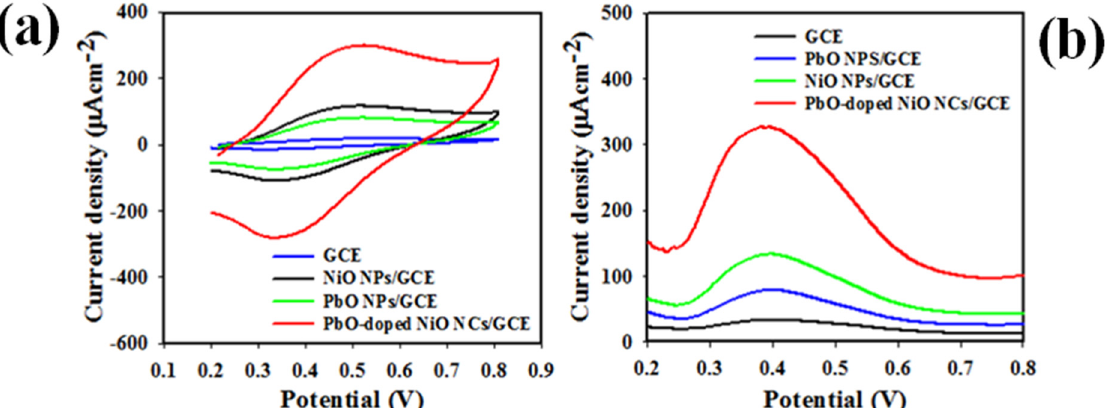
Figure 11. The control experiments for UA applying CV and DPV. ( a ) Current density versus ap- plied potential of UA responses at 0.6 mM concentration for constituting single metal oxides com- pared with binary NCs of PbO-doped NiO applying CV and ( b ) similar experiments for UA apply- ing